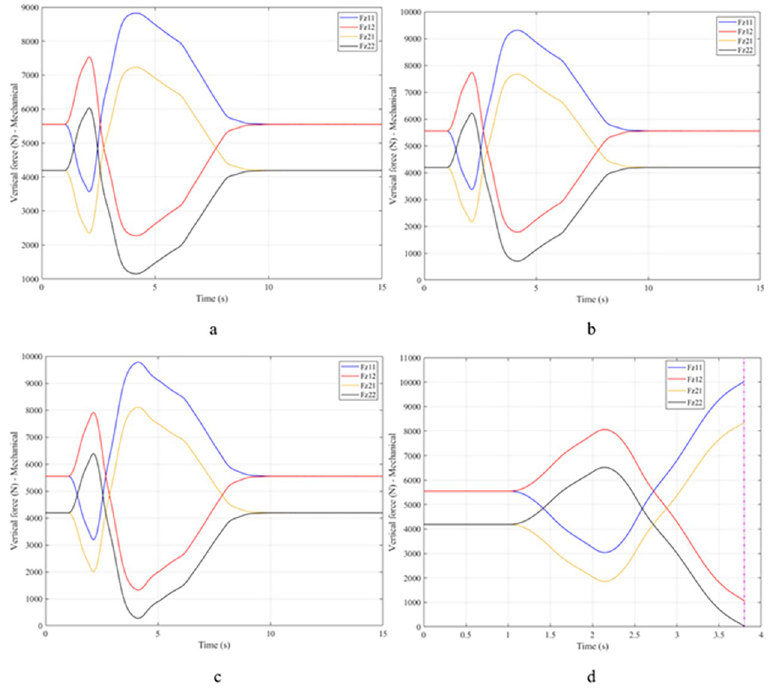
Fig 19. Vertical force–Mechanical.